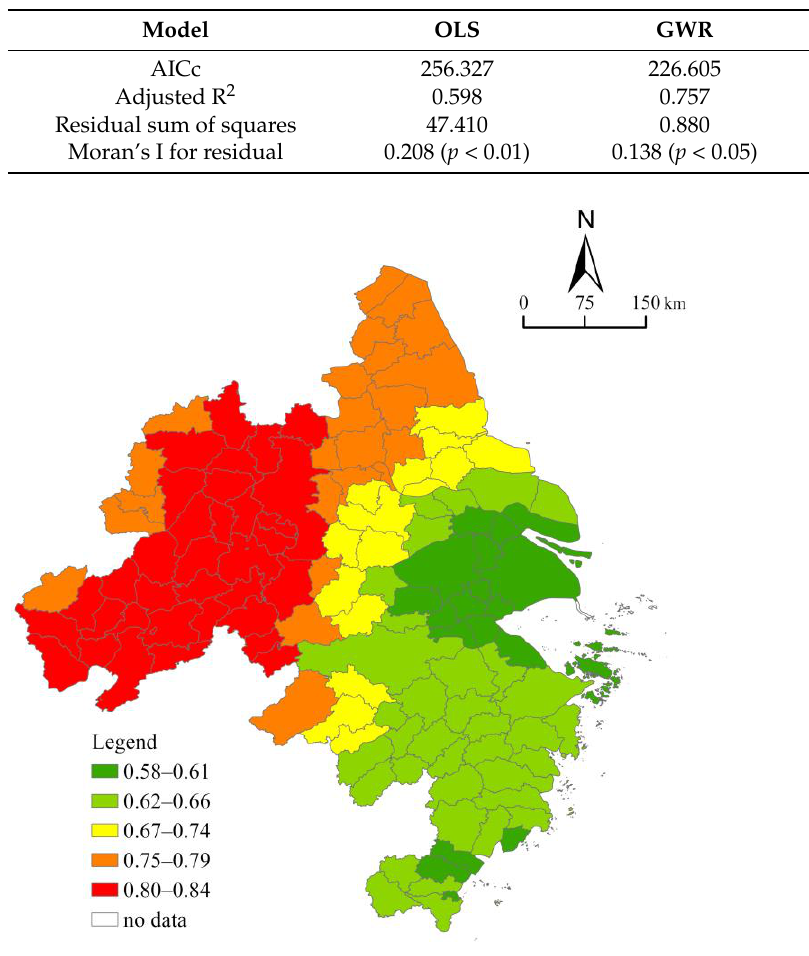
Figure 7. Local R 2 of MGWR model fitting results.